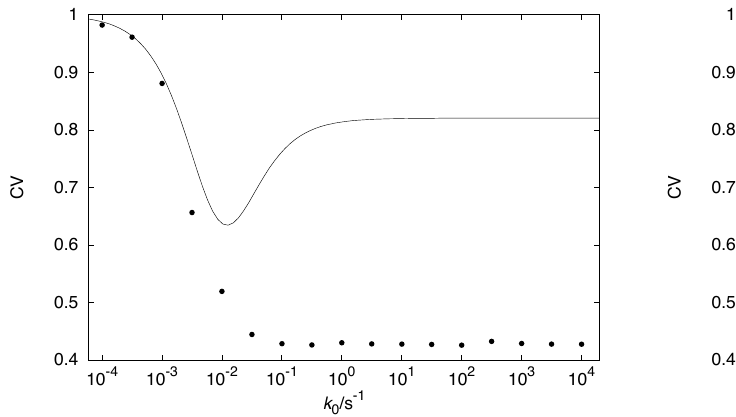
Fig. 7. CV [equation (33)] vs k 0 for k 1 = 5 s − 1 , k 2 = 10 s − 1 , k 3 = 100 s − 1 , k 4 = 0 . 01 s − 1 , n = 200 nt and ∆ = 40 nt . The solid curve is the CV computed from the analytic theory, i.e. equation (34). The points are from stochastic simulations. For each value of k 0 , the model was simulated until 100000 RNAs had been synthesized.